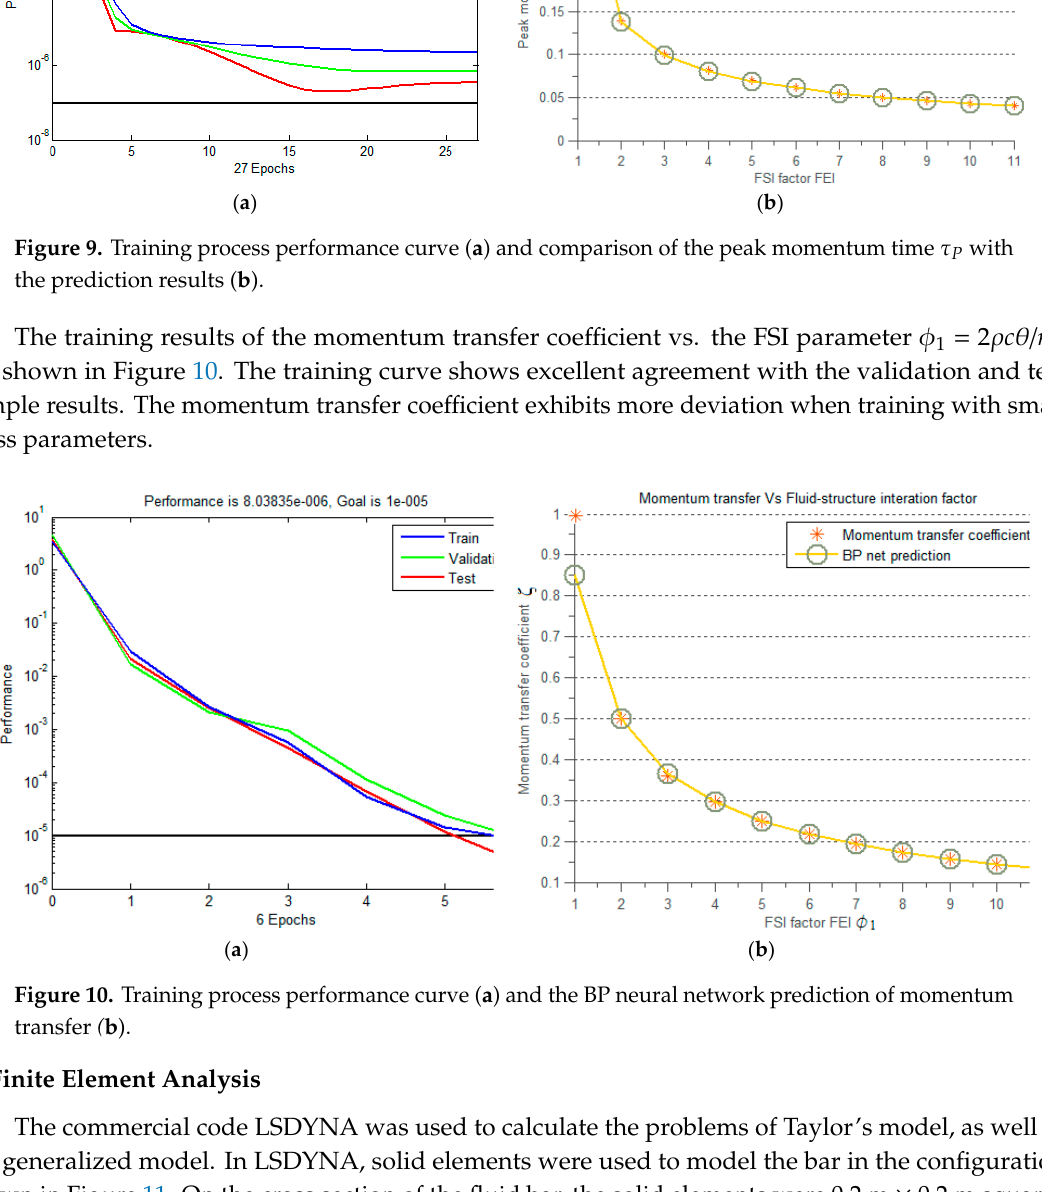
Figure 11. The model in LSDYNA for Taylor’s problem. The rigid plate with water on one side and with air on the other side.